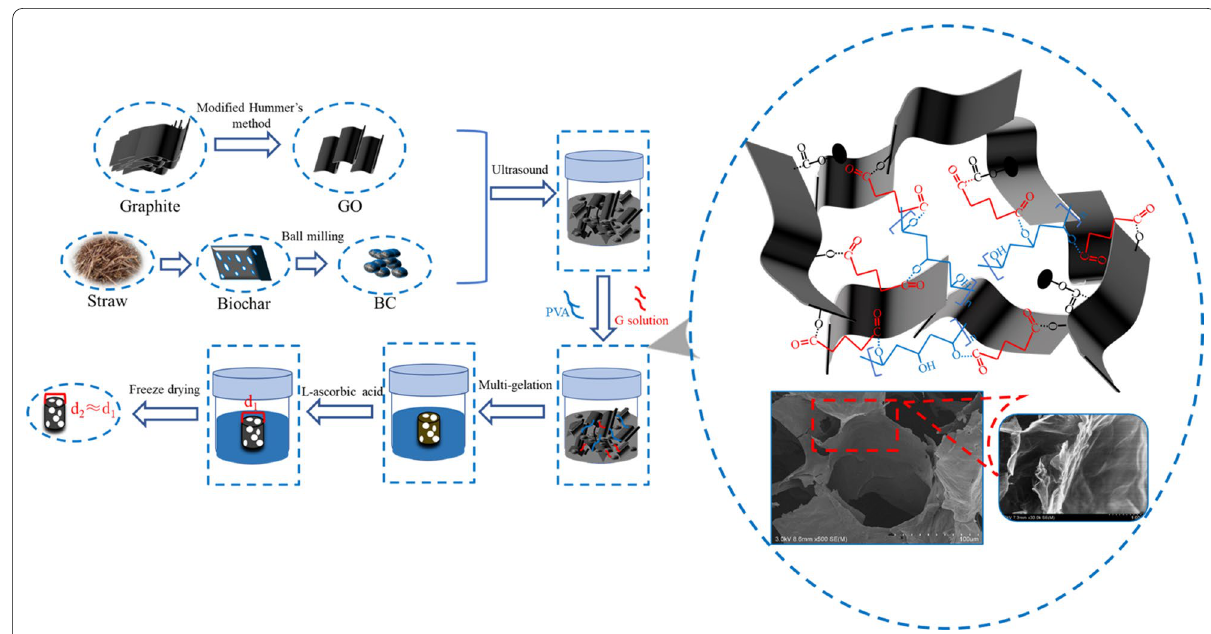
Fig. 3 Schematic of synthesis progress of BC/rGA